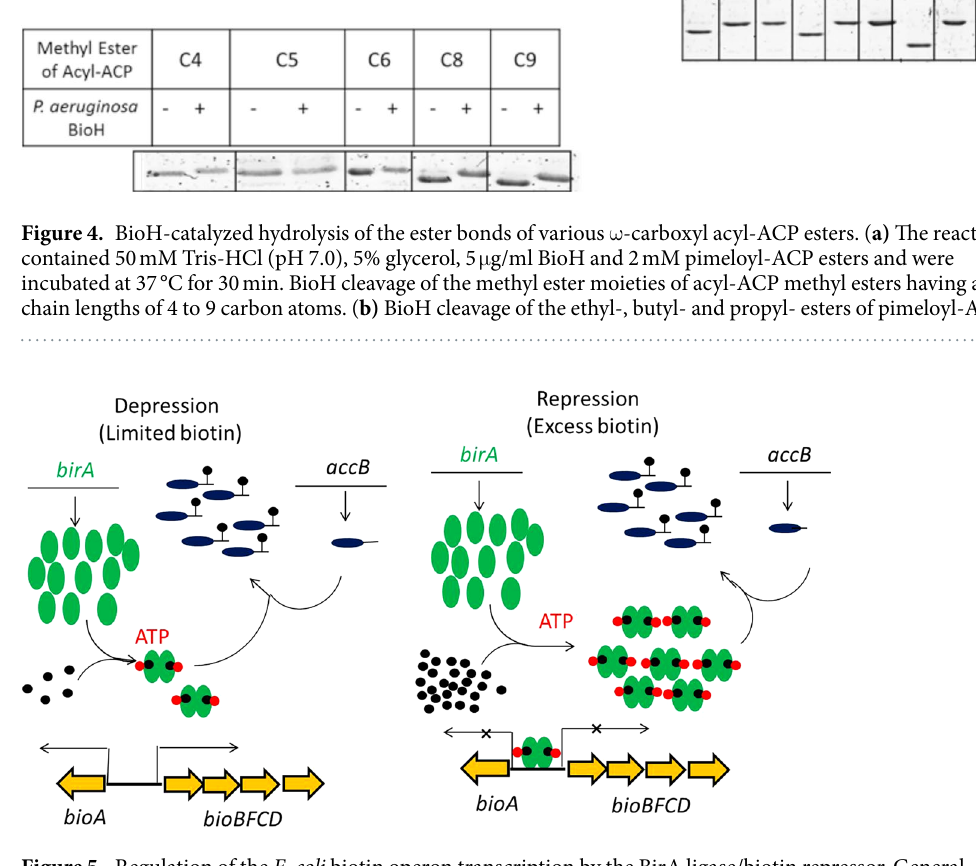
Figure 5. Regulation of the E. coli biotin operon transcription by the BirA ligase/biotin repressor. General model of BirA bio operon regulation in E. coli . Green ovals denote BirA; tailed blue ovals denote the biotin acceptor protein, AccB; black dots denote biotin; black dots with red pentagons denote biotinoyl-5 ′ -adenylate. The left panel shows derepression of bio operon transcription engendered by biotin limitation whereas the right panel shows the transcriptionally repressed state under excess